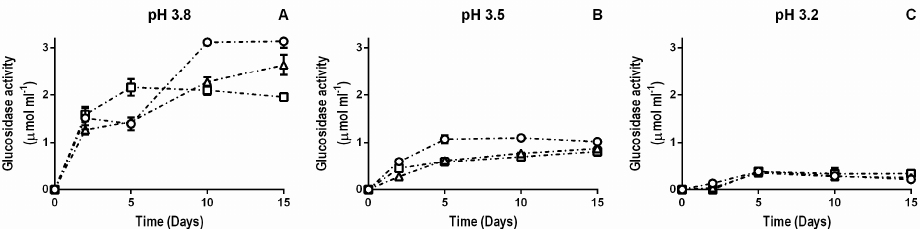
Figure 2. β -glucosidase activity of UNQLp 11 during fermentation in synthetic wine with different ethanol content (0% ( □ ), 12% ( ), and 14% v/v ( ○ ), at different pH values: 3.8 ( A ), 3.5 ( B ), and 3.2 ( C ). The results are expressed as µmol mL -1 of p-nitrophenol (p-NP).